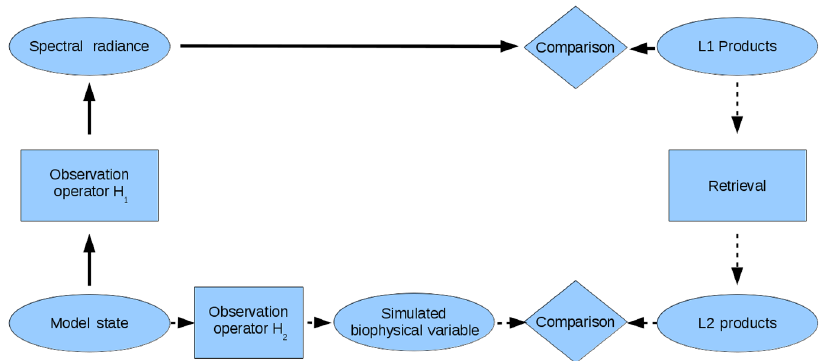
Figure 2. Model–data comparison at the sensor level (level 1, solid arrows) and at the level of geophysical variables (level 2, dotted arrows). Ovals denote data, and rectangles denote some form of